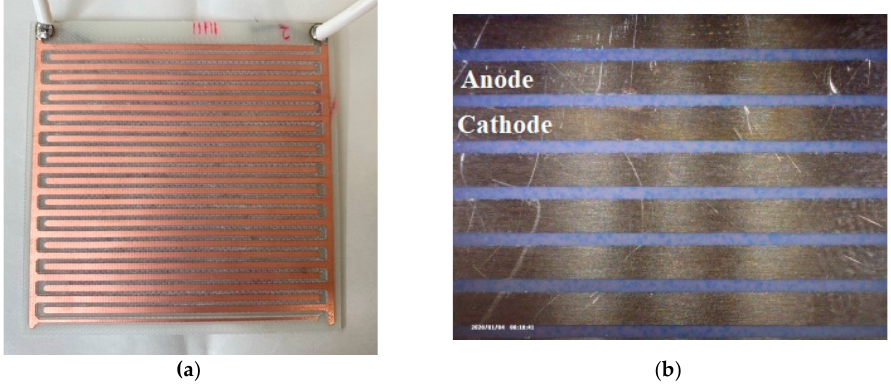
Figure 1. Electrode structure and photograph. The anode and cathode are arranged alternately in a comb-shaped electrode. The D. gallinae pass between these electrodes and are killed. ( a ) Photo of electrodes (glass epoxy) ( b ) Enlarged view of substrate (0.5 mm between electrodes).